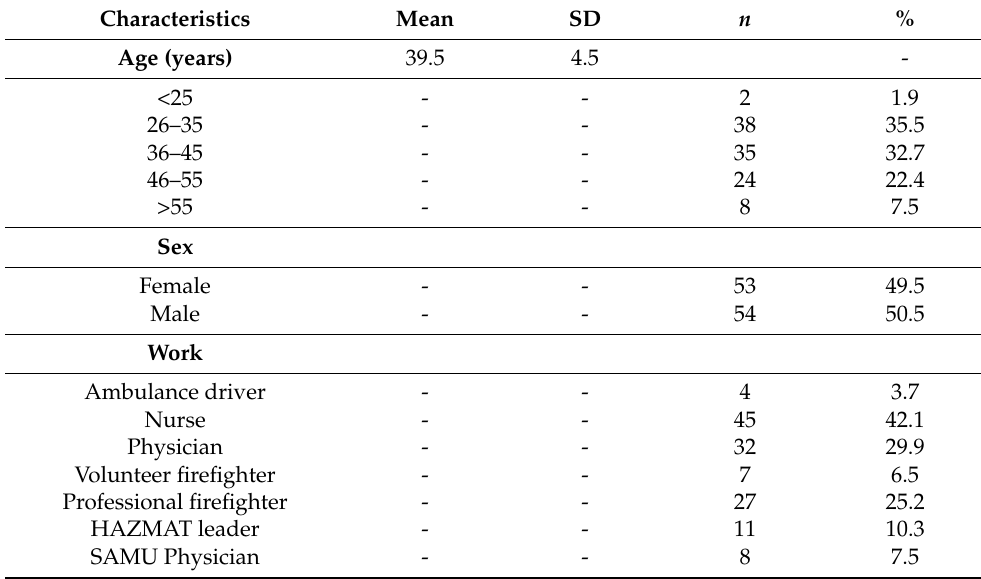
Table 1. Sociodemographics. SD = standard deviation, HAZMAT = hazardous materials, SAMU = Ser- vice d’Aide M é dicale